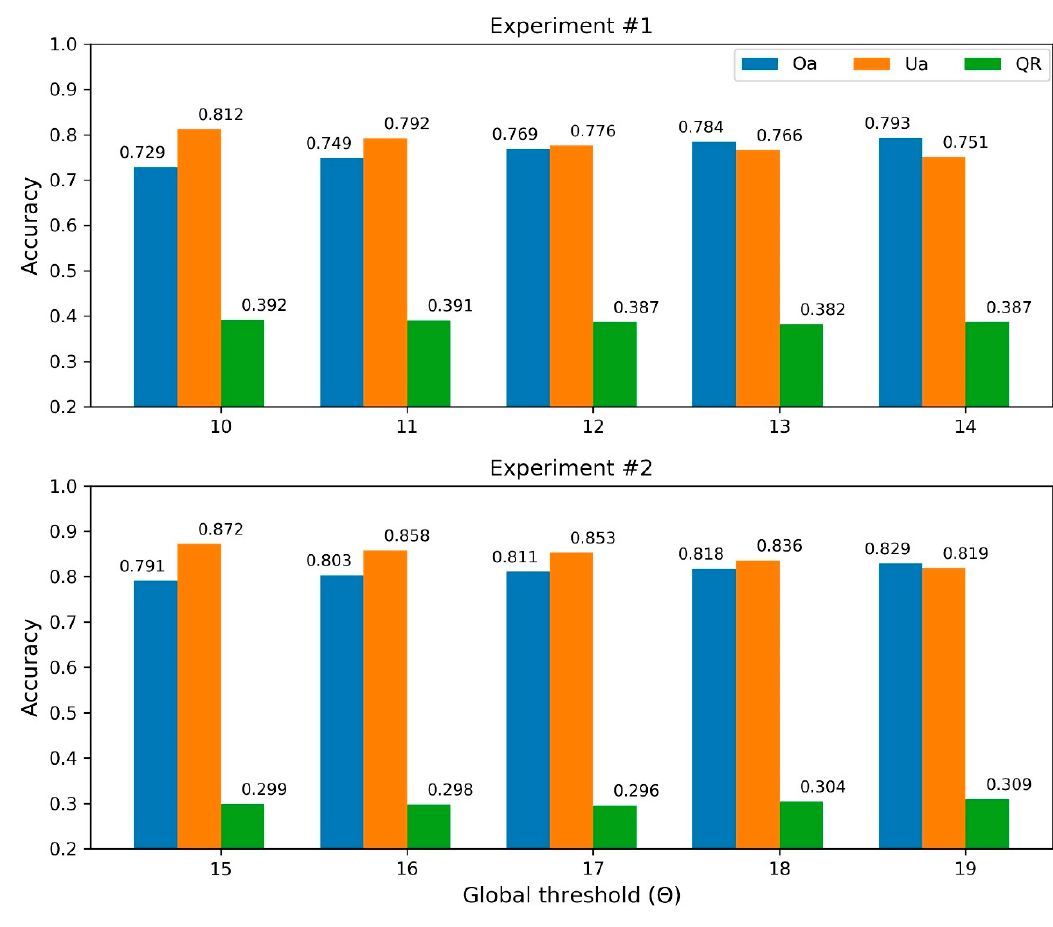
Figure 4. Segmentation accuracy of Individual tree crowns (ITC) under different global thresholds.